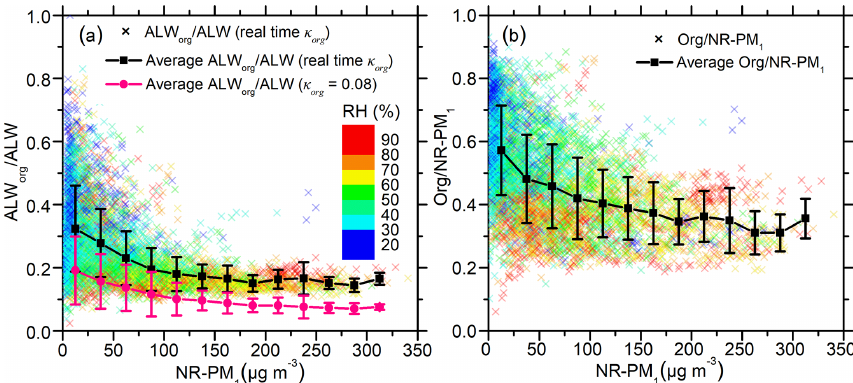
Figure 1. (a) The coloured scatter points represent the fraction of aerosol liquid water contributed by organics (ALW org / ALW), which was calculated using real-time κ org . The black line shows the average of the coloured points in each NR-PM 1 mass concentration bin. The pink line is the average ALW org / ALW calculated using a fixed κ org (0.08) in each NR-PM 1 mass concentration bin. (b) The coloured scatter points represent the organic mass fraction in non-refractory submicron aerosol (NR-PM 1 ). The black line is the average of the coloured points in each NR-PM 1 mass concentration bin. All the scattered points in both figures are coloured with relative humidity (RH).